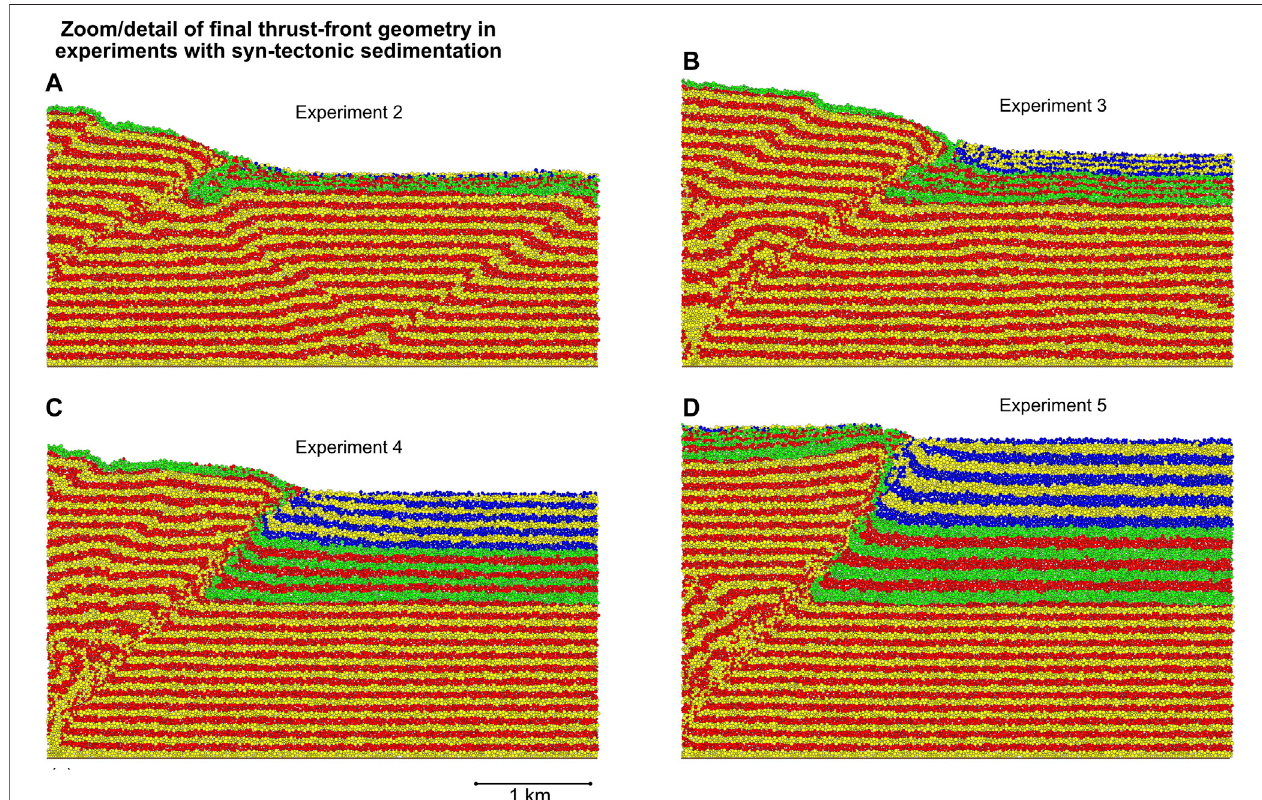
FIGURE10| Zoom/detailofthrustfrontinallmodels(Experiments2 – 5)withsyn-tectonicsedimentationafter20%shorteningattheendofthemodelruns.Seetext for discussion.